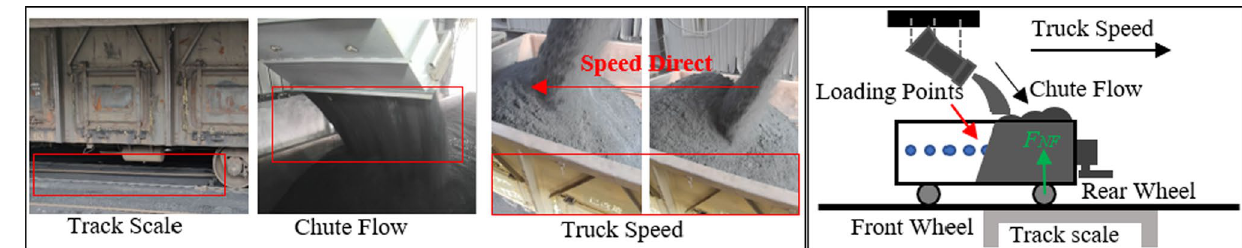
Fig. 1 The diagram of multi-adjustment